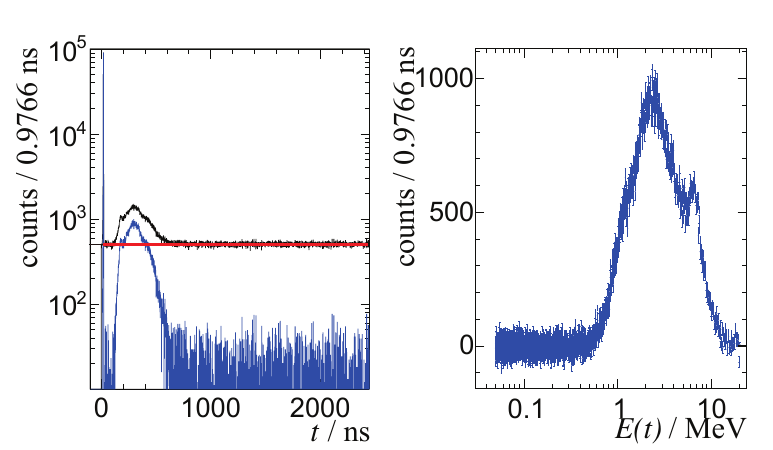
Figure 2. Left : neutron time-of-flight spectrum acquired by one channel of the plutonium fission chamber before (in black) and after (in blue) background subtraction. The red line indicates a constant extrapolation of the background induced by room-returned neutrons and spontaneous fission events. Right : background subtracted energy spectrum calculated using the time-of-flight spectrum shown on the left